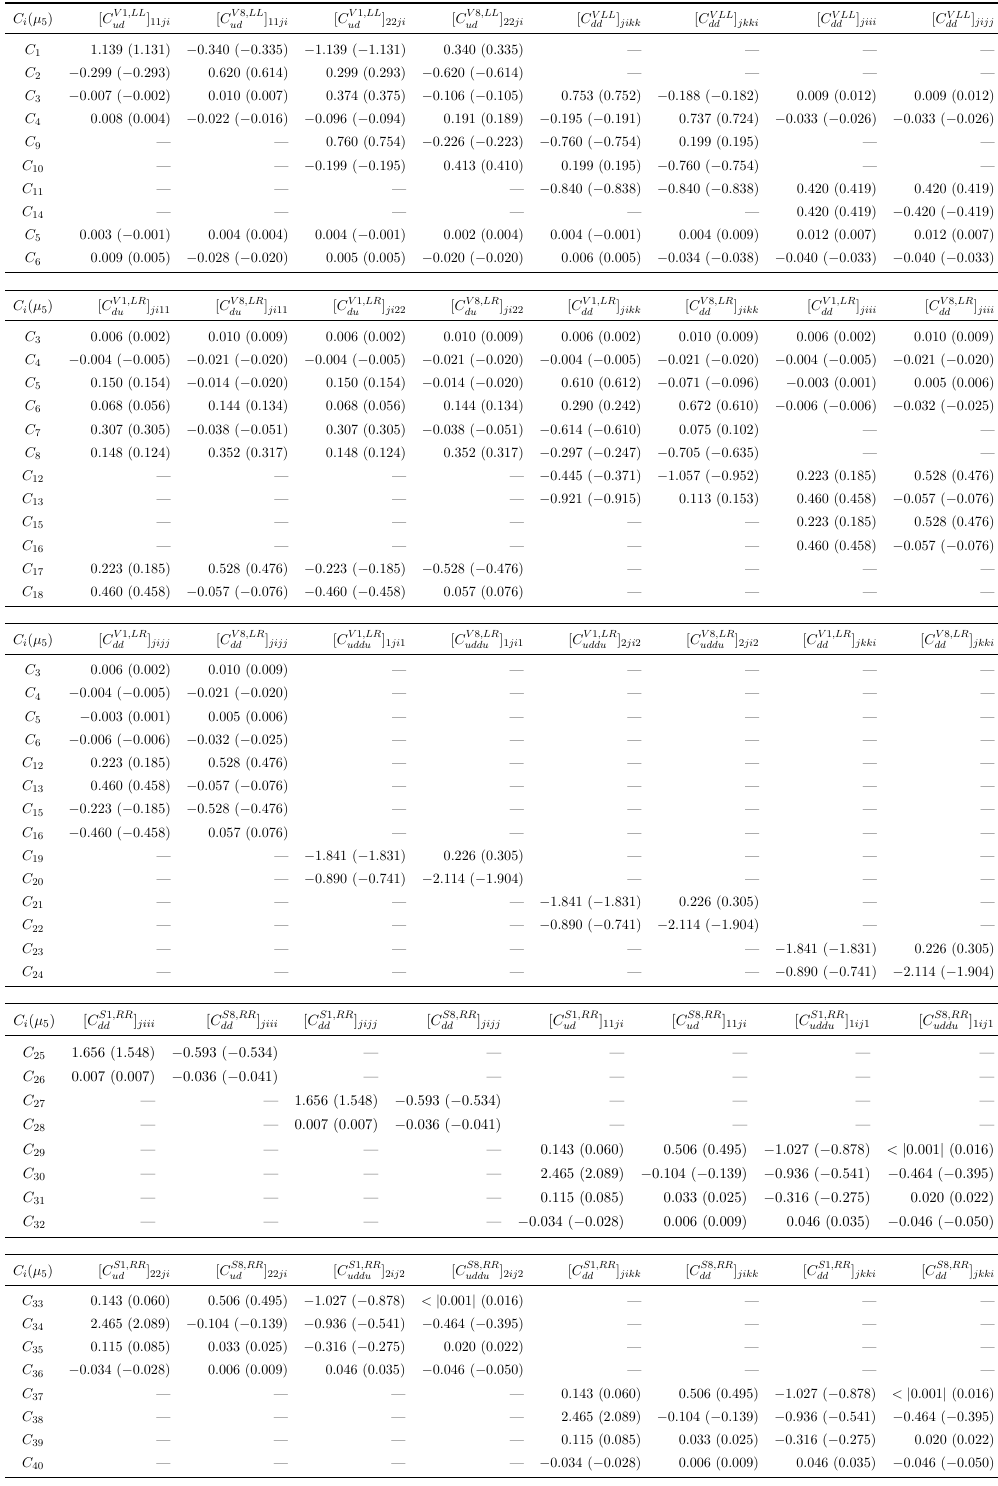
Table 2 . The elements u ab ( µ had , µ ew ) of the NLO (LO) RG evolution operator in eq. (6.6) for N f = 5 . They connect the JMS Wilson coefficients at µ ew = 160 GeV to the BMU ones at µ had = µ 5 = 4 . 2